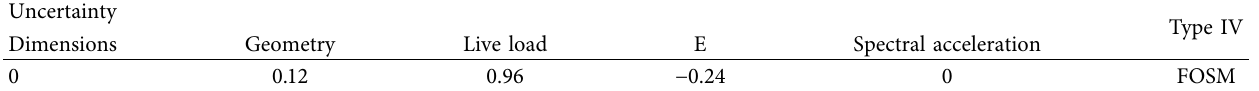
Table 9: Results of the scale of significance of uncertainties in FOSM analysis of type IV headed frames.